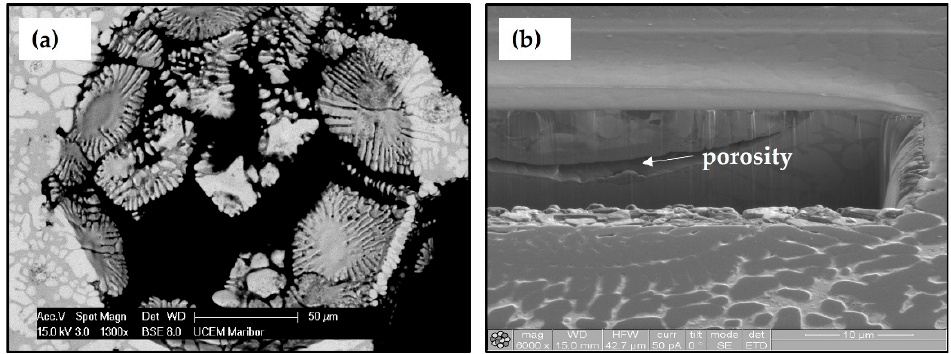
Figure 3. Presentation of the hole and crack ( a ) SEM presentation of the hole formed by the dropout of the sphere and ( b ) FIB presentation of the crack.